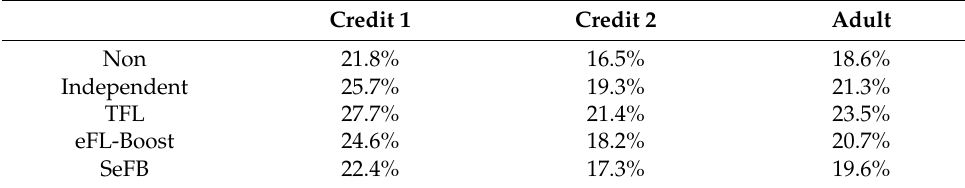
Table 5. Test errors of different